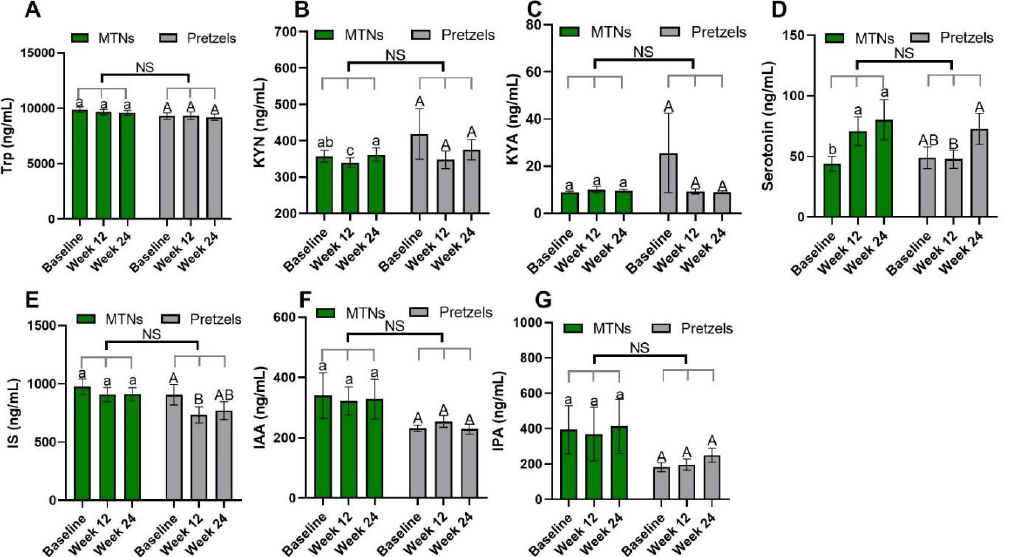
Figure 2. Levels of plasma Trp ( A ) and Trp metabolites, ( B ) KYN, ( C ) KYNA, ( D ) serotonin, ( E ) IS, ( F ) IAA, and ( G ) IPA at baseline, week 12, and week 24 in pretzel group ( n = 38) and MTNs group ( n = 56). The results are presented as mean values with SEM. For within-group analysis (lower case for MTNs; upper case for pretzels), means in a column without a common letter differ; p < 0.05. Changes from baseline were analyzed and no between-groups significant difference (NS) was detected.